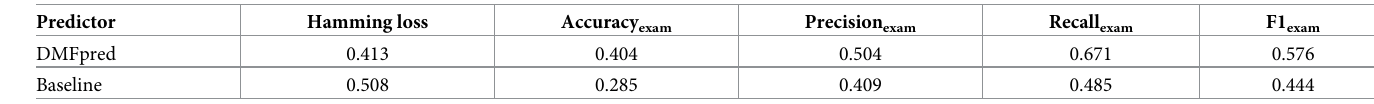
Table 3. The predictive results for multi-functional residues on TEST-1 independent test set.